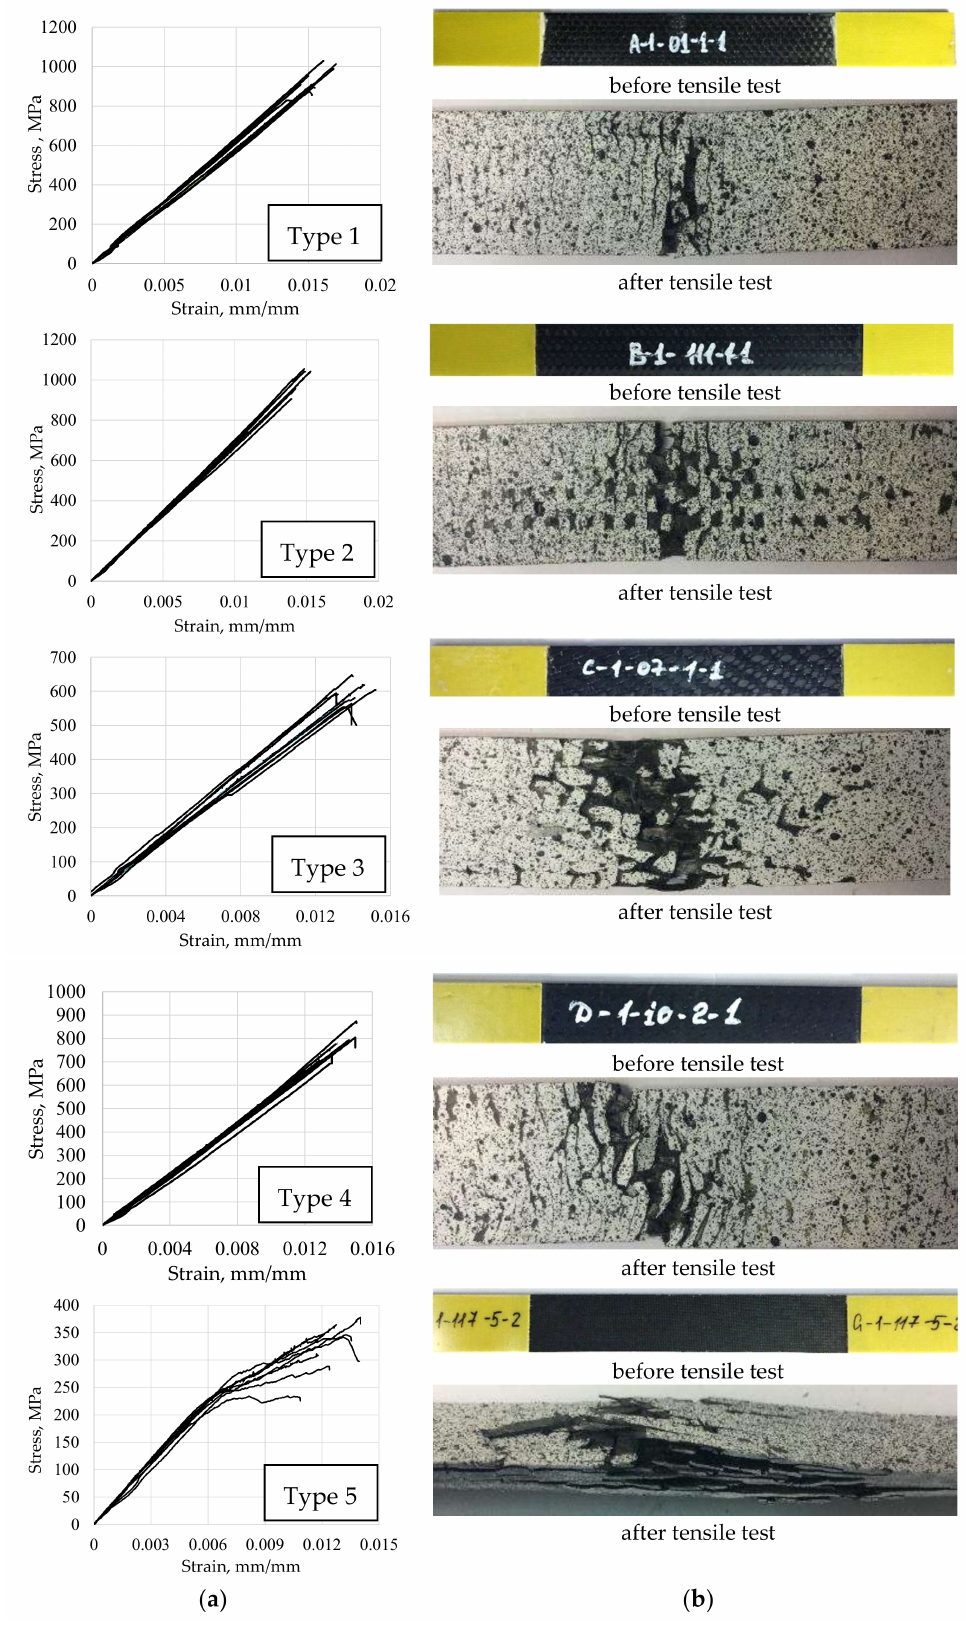
Figure 3. Deformation diagrams ( a ) and view of CFRP specimens of various reinforcement schemes before and after ( b ) the uniaxial tensile test (according to ASTM D